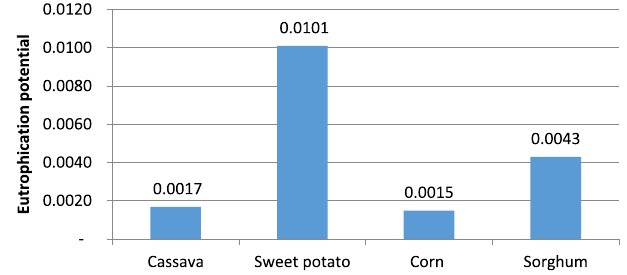
Figure 5. Eutrophication potential.